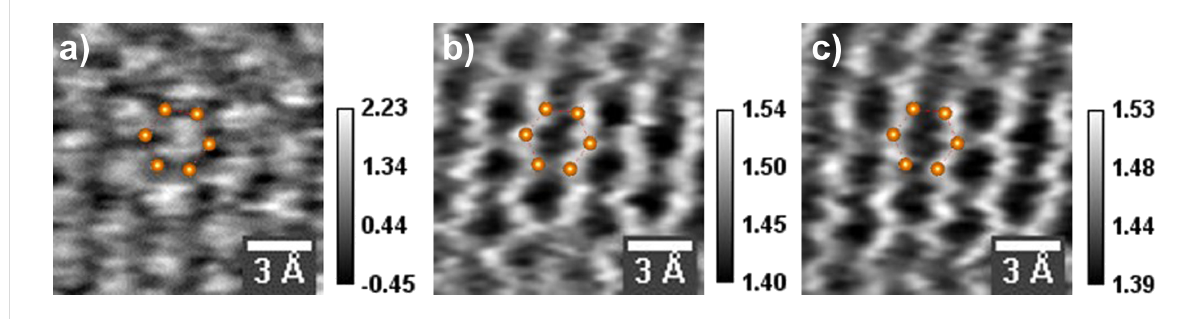
Figure 1: Simultaneous STM/AFM images of a graphene surface on a Cu substrate. (a) STM topography in constant-current mode (forward scan); (b) force in constant-current mode (forward scan); (c) force in constant-height mode (backward scan). Scale bar values are in units of Å in STM and nN in force images. Obtained with a W tip and cantilever of stiffness k = 53 N/m and a resonance frequency f 0 = 31.5 kHz; drive frequency f = 15 kHz. The image size is 11 × 11 Å 2 , V sample = − 0.5 V, I t = 1.2 nA, free amplitude A 0 = 0.3 Å rms . A hexagonal unit cell is